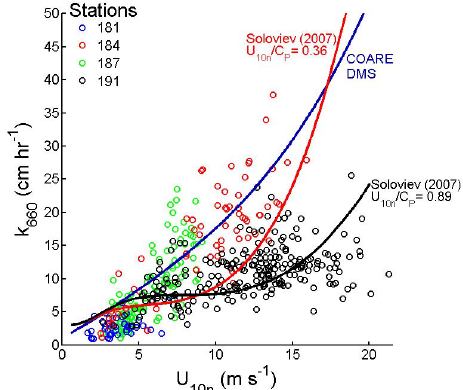
Fig. 8. Measured and modelled DMS gas transfer coefficients. Sym- bols: Knorr_11 station data. Curves: model simulations from the COARE 3.1 DMS parameterization which does not include waves (blue) and the Soloviev (2007) parameterization using mean in- verse wave age from station 184 ( U 10 n /C P = 0 . 36) and station 191( U 10 n /C P = 0 .